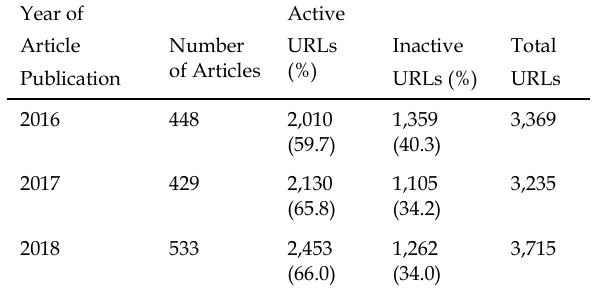
Table 2: Number and percentage of active and inactive URLs by year of publication Year of